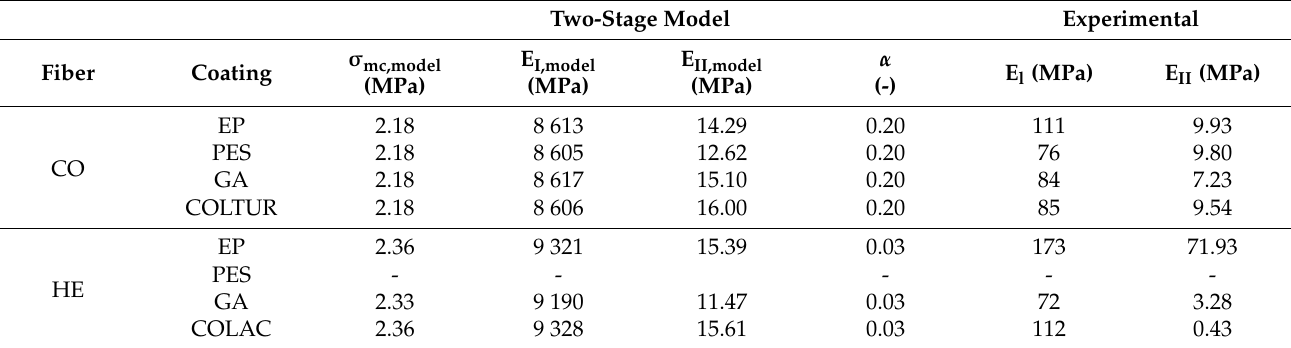
Table 11. Experimental and two-stage model